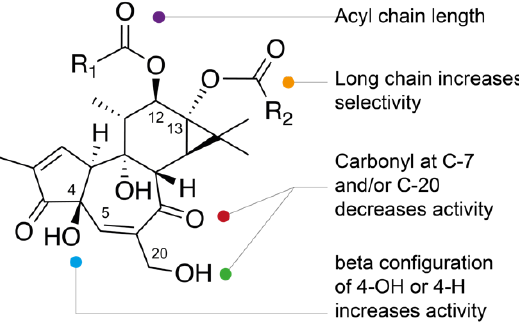
Figure 2. Structure–activity relationships of tiglianes.